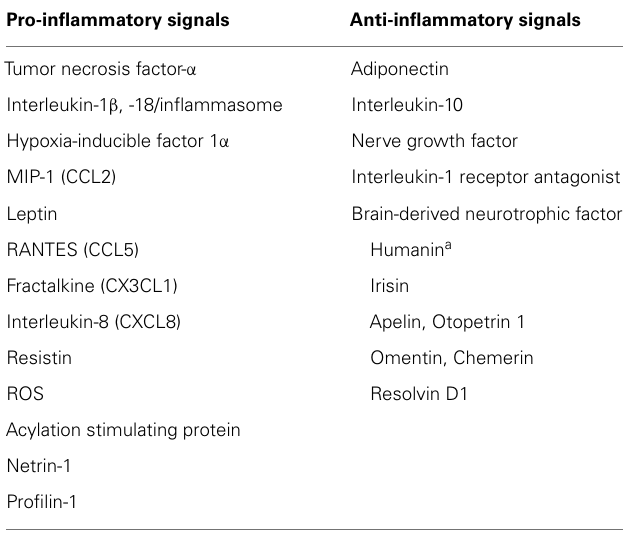
Table 2 | Selected list of pro- and anti-inflammatory adipose-derived signals relevant to cardiovascular disease